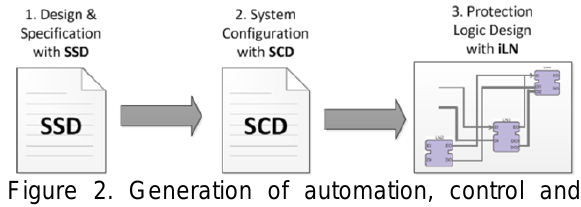
Figure 2. Generation of automation, control and protection logic corresponding to the customer